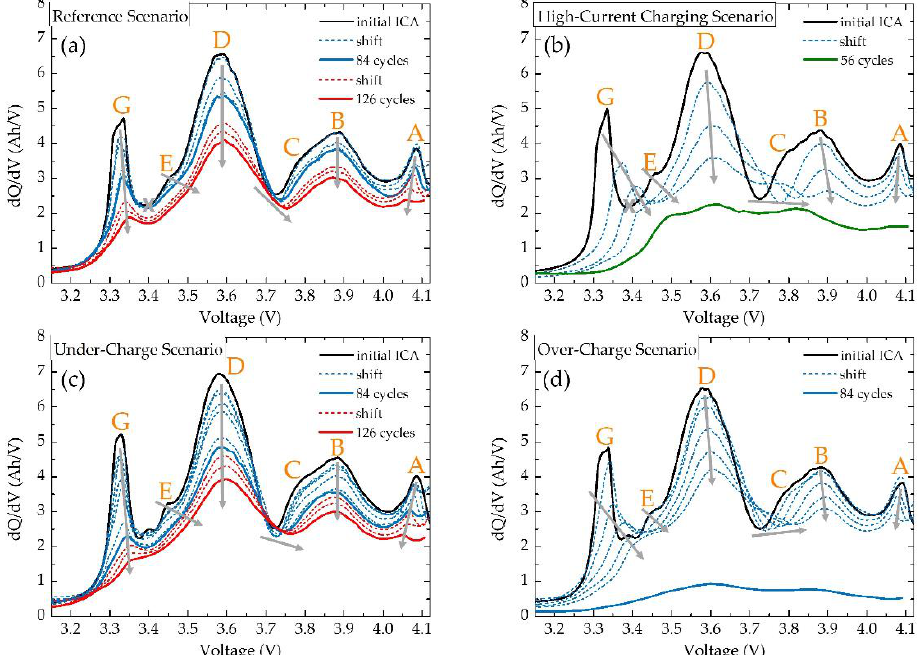
Figure 11. Incremental capacity analysis of studied batteries, where six dominant features are recognised and studied for ( a ) Reference Scenario, ( b ) High-Current Charging Scenario, ( c ) Under-Charge Scenario and ( d ) Over-Charge Scenario .